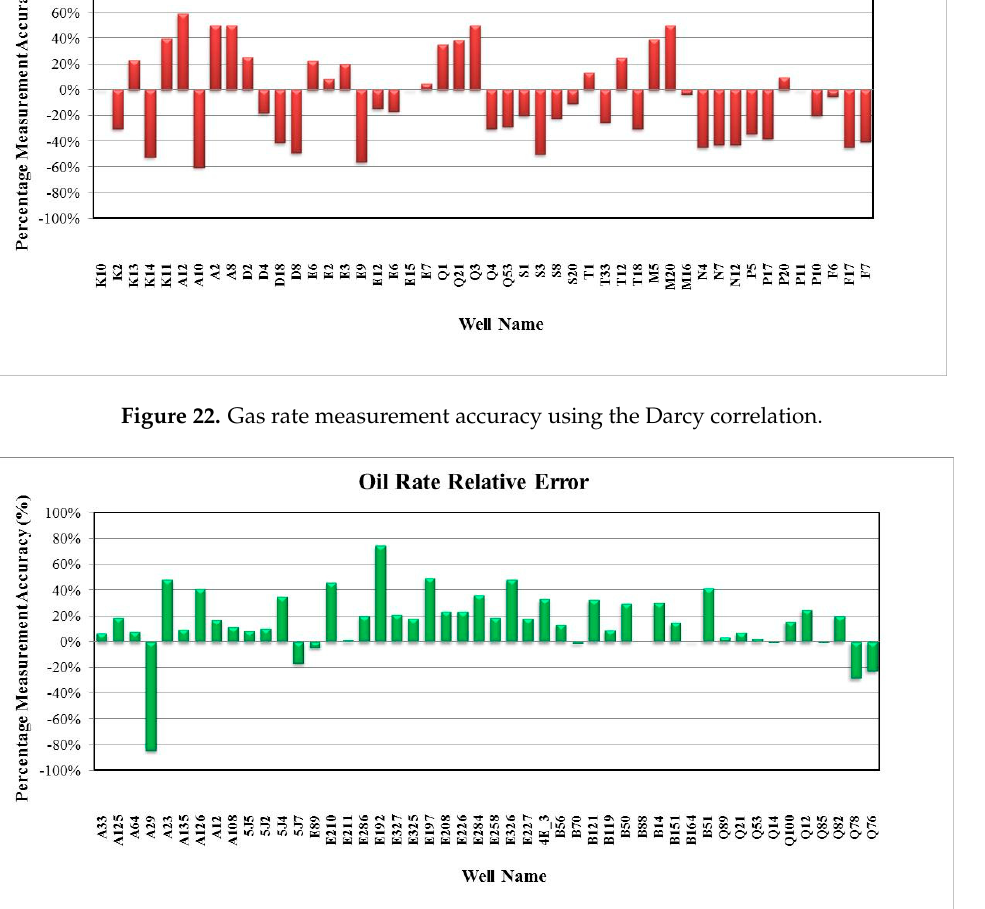
Figure 23. Oil rate measurement accuracy using the Colebrook correlation.